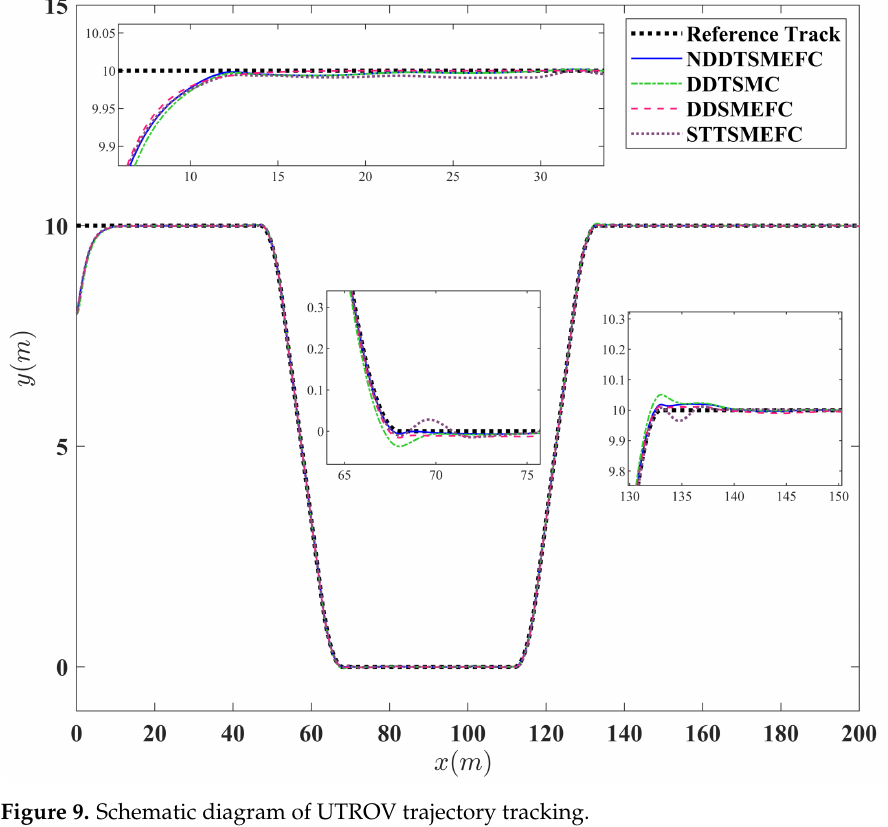
Figure 9. Schematic diagram of UTROV trajectory tracking.